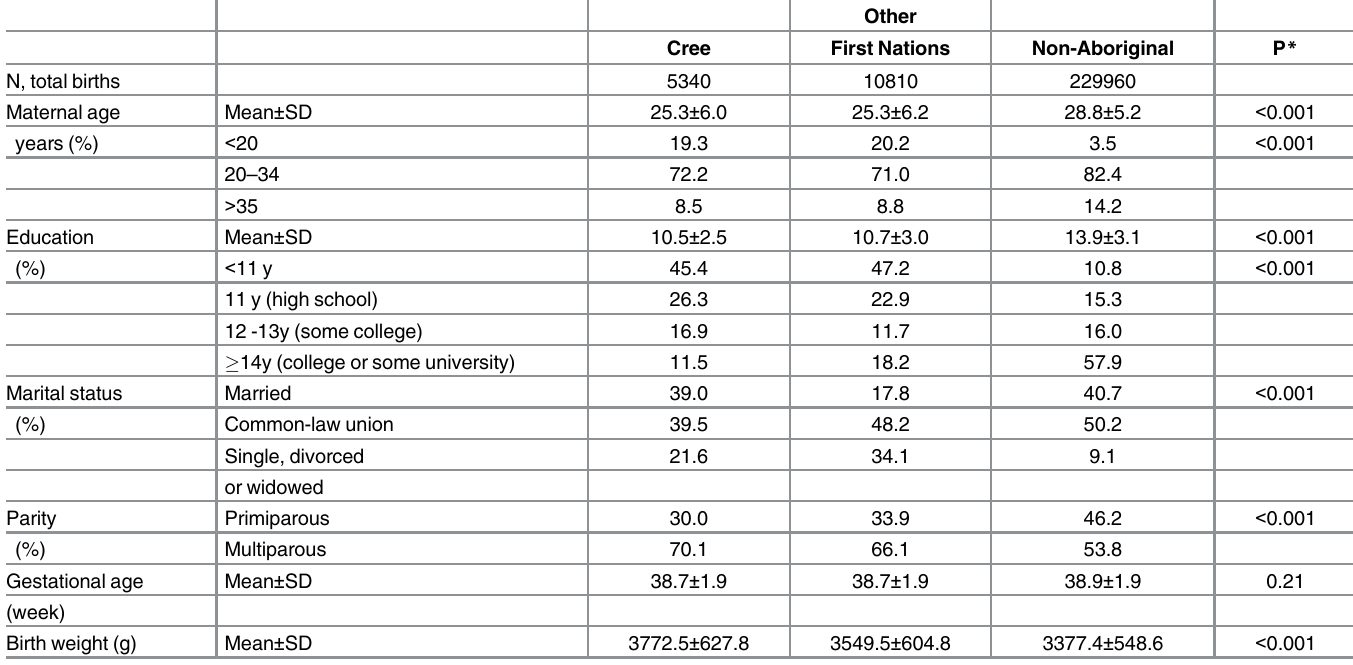
Table 1. Characteristics of singleton births in Cree, other First Nations and Non-Aboriginal communities in Quebec, 1996 – 2010.